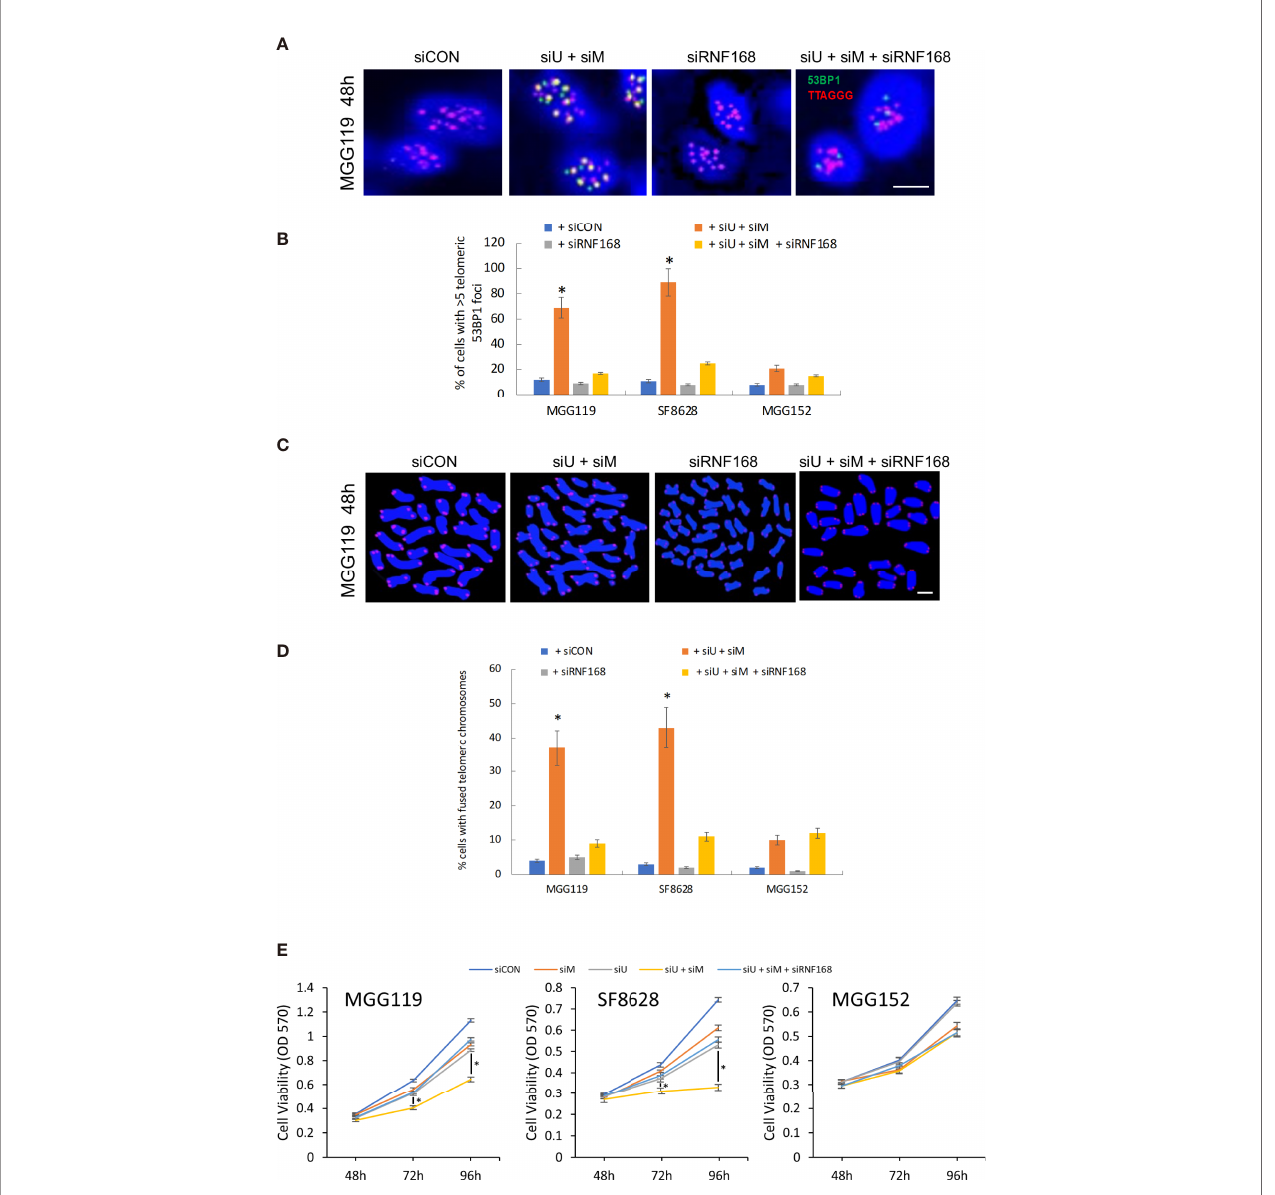
FIGURE 4 | (A) Representative images of colocalized (yellow) immuno fl uorescence from a telomeric probe (TTAGGG, red) and a 53BP1 probe (green) in DAPI- stained MGG119 cells after 48 hours exposure to s scrambled siRNA control (siCON) or pooled siRNA targeting RNF168 (siRNF168), MRE11 and UBR5 (siU+siM) or adding siRNF168 (siU+siM+siRNF168). Scale bar, 10 m m. (B) Percentage of cells with >5 telomeric 53BP1 foci. Statistical signi fi cance relative to control (siCON) is indicated. Data are the means of triplicate samples ± SD derived from groups of >100 cells. *P < 0.05. (C) Representative image of MGG119 cells after 48 hours exposure to scrambled siRNA control (siCON) or pooled siRNA targeting RNF168 (siRNF168), MRE11 and UBR5 (siU+siM) or adding siRNF168 (siU+siM+siRNF168). DAPI is blue and telomere-speci fi c probe is red. scale bar, 10 m m. (D) Percentage of cells with >1 telomere-fused chromosome in metaphase spreads 48 hours after the indicated siRNA exposure. Signi fi cance relative to nontargeted (siCON) are indicated. *P < 0.05 (E) Cell proliferation were measure by MTT assay at 48, 72 and 96 hours post siRNA exposure. Data are represented as the means ± SD of 3 independent experiments. *P <